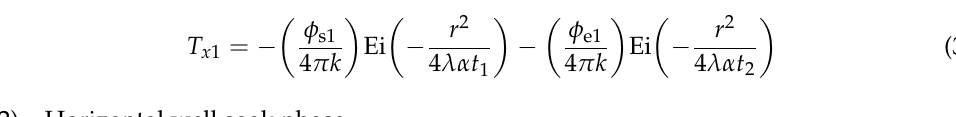
Figure 1. 2D cross-section map of horizontal wellbore during steam injection. Substituting Formula (1) into Formula (2) can obtain the elevated temperature at any point x on the two-dimensional